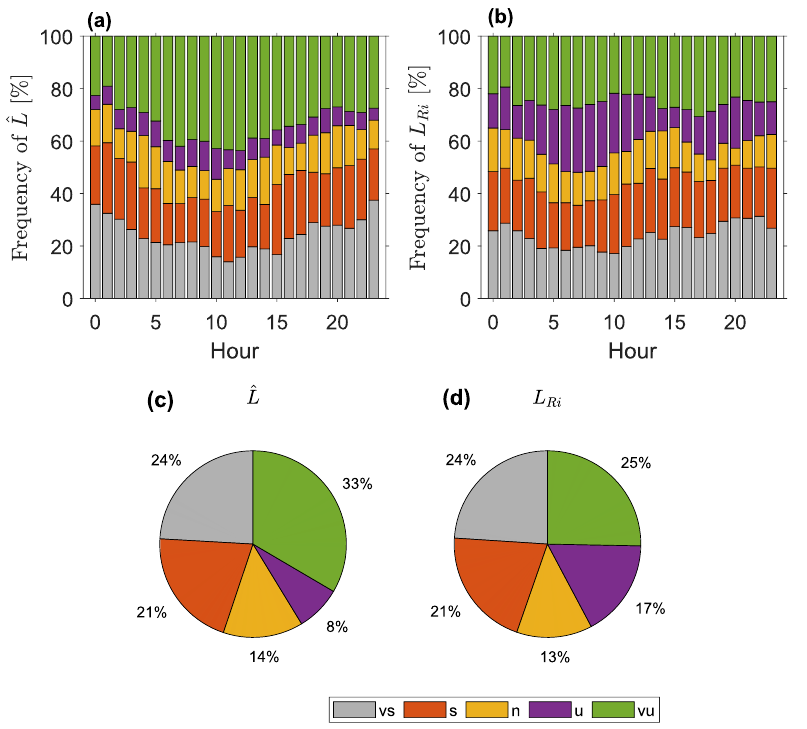
Figure 11. Overall campaign stability classification results (Van Wijk et al. [50] criterion). ( a , b ) Stability histograms showing the relation between frequency of occurrence of each stability class clustered by hour of the day. ( c , d ) Corresponding stability pie charts showing the estimated Obukhov length, ˆ L ( c ), and the Richardson reference, L Ri ( d